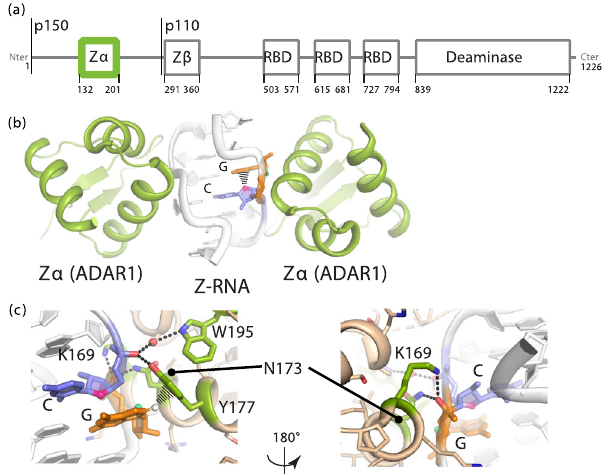
Fig. 1 The Z α domain of ADAR1p150 binds to Z-RNA. a Domain organization of ADAR1: Z α and Z β are structurally homologous helix-turn- helix DNA-binding domains, RBD stands for double-stranded RNA binding domain. Both isoforms are indicated. b Crystal structure of (CpG) 3 bound to Z α from ADAR1 (PDB ID: 2GXB) 25 . c Close-up of the RNA-protein